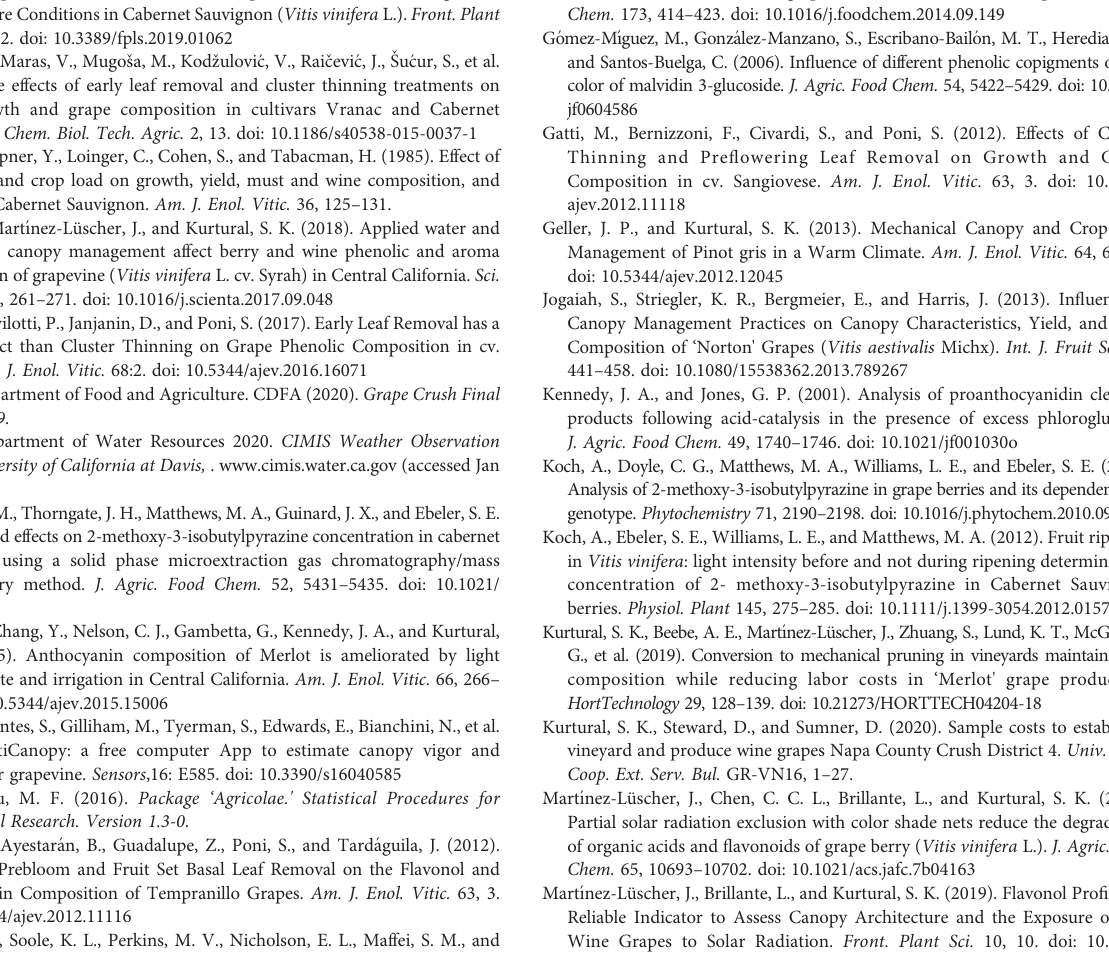
Affected by Light Exposure and Crop Level in Cabernet Sauvignon. Am. J. Enol. Vitic. 64, 450 – 458. doi: 10.5344/ajev.2013.13070 Feng, H., Yuan, F., Skinkis, P. A., and Qian, M. C. (2015). In fl uence of cluster zone leaf removal on Pinot noir grape chemical and volatile composition.